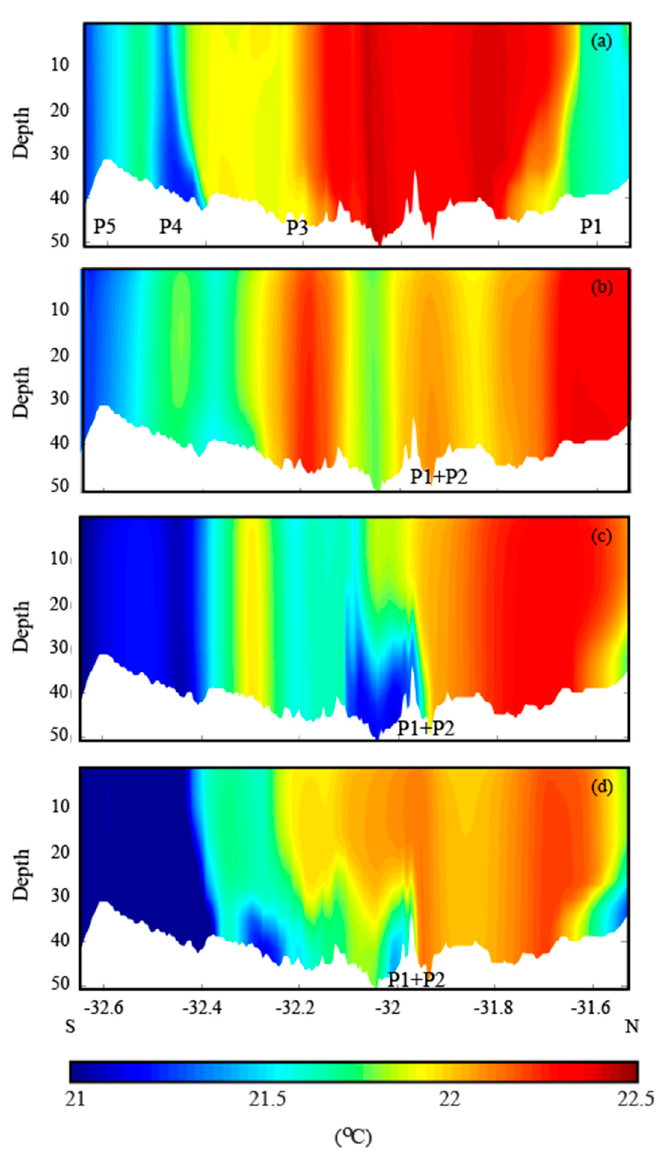
Figure 13. As for Figure 9 but during strong wind conditions (20 ms − 1 ): ( a ) May 20, 2016; ( b ) May 21, 2016; ( c ) May 22, 2016; and ( d ) May 23, 2016.